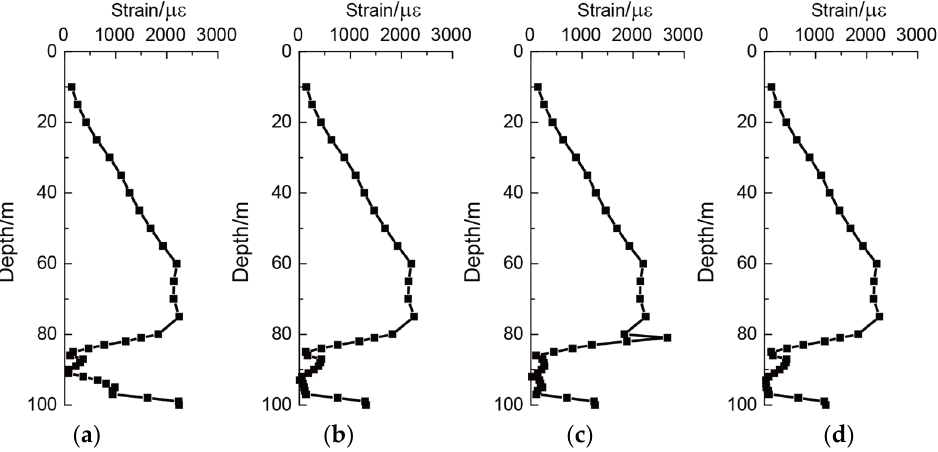
Figure 10. Results of the rock-socketed piles with different DCs of karst caves under pile. ( a ) DC at 1, ( b ) DC at 1.5, ( c ) DC at 2, and ( d ) DC at 3. ( b ) DC at 1.5, ( c ) DC at 2, and ( d ) DC at